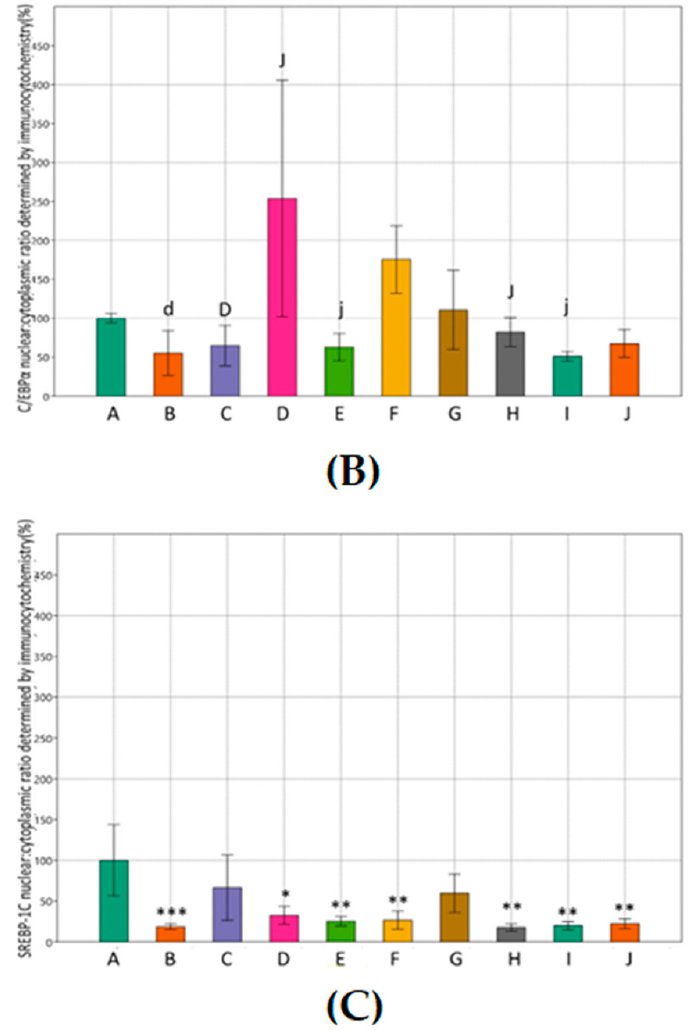
Figure 5. Effects of metformin and simvastatin on nuclear: cytoplasmic ratio of adipogenic proteins in 3T3-L1 cells, determined by immunocytochemistry. A = differentiated cells, B = cells treated with metformin 200 µ M, C = cells treated with metformin 2 mM, D = C = cells treated with metformin 4 mM, E = cells treated with simvastatin 100 nM, F = cells treated with simvastatin 1 µ M, G = cells treated with simvastatin 2 µ M, H = cells treated with the combination of metformin 200 µ M and simvastatin 100 nM, I = cells treated with the combination of metformin 2 mM and simvastatin 1 µ M, J = cells treated with the combination of metformin 4 mM and simvastatin 2 µ M, PPAR γ = peroxisome proliferator-activated receptor γ , C/EBP α = CCAAT/enhancer binding protein α , SREBP-1C = sterol regulatory element-binding protein 1. The data are shown as the means ± SD (standard deviation) from three independent experiments. Data represents a percentage relative to differentiated cells as the control group. ( A ) Effects of metformin and simvastatin on nuclear: cytoplasmic ratio of PPAR γ during the differentiation of 3T3-L1 cells (One-way ANOVA F(9,26) = 2.006, p = 0.1034 with Tukey HSD post hoc test); ( B ) effects of metformin and simvastatin on nuclear: cytoplasmic ratio of C/EBP α during the differentiation of 3T3-L1 cells (One-way ANOVA F(9,31) = 3.993, p = 0.003855 with Tukey HSD post hoc test; * p < 0.05, ** p < 0.01); ( C ) effects of metformin and simvastatin on nuclear: cytoplasmic ratio of SREBP-1C during the differentiation of 3T3-L1 cells (One-way ANOVA F(9,34) = 5.666, p = 0.0002732 with Tukey HSD post hoc test; * p < 0.05, ** p < 0.01, *** p < 0.001).